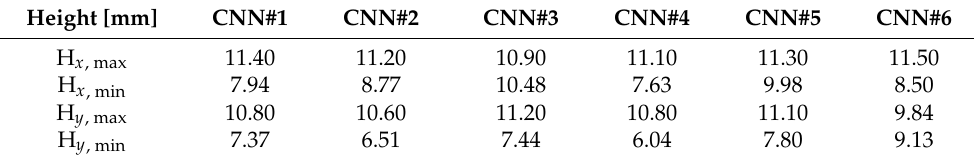
Table 4. Height features of the derived preform shapes for the grinding tool-like shape.